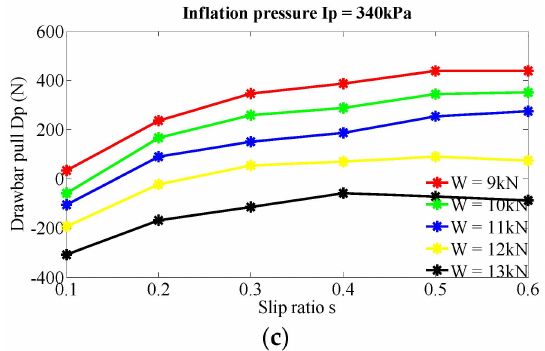
Figure 7. Effect of slip ratio on the drawbar pull at various levels of vertical load and inflation pressure.